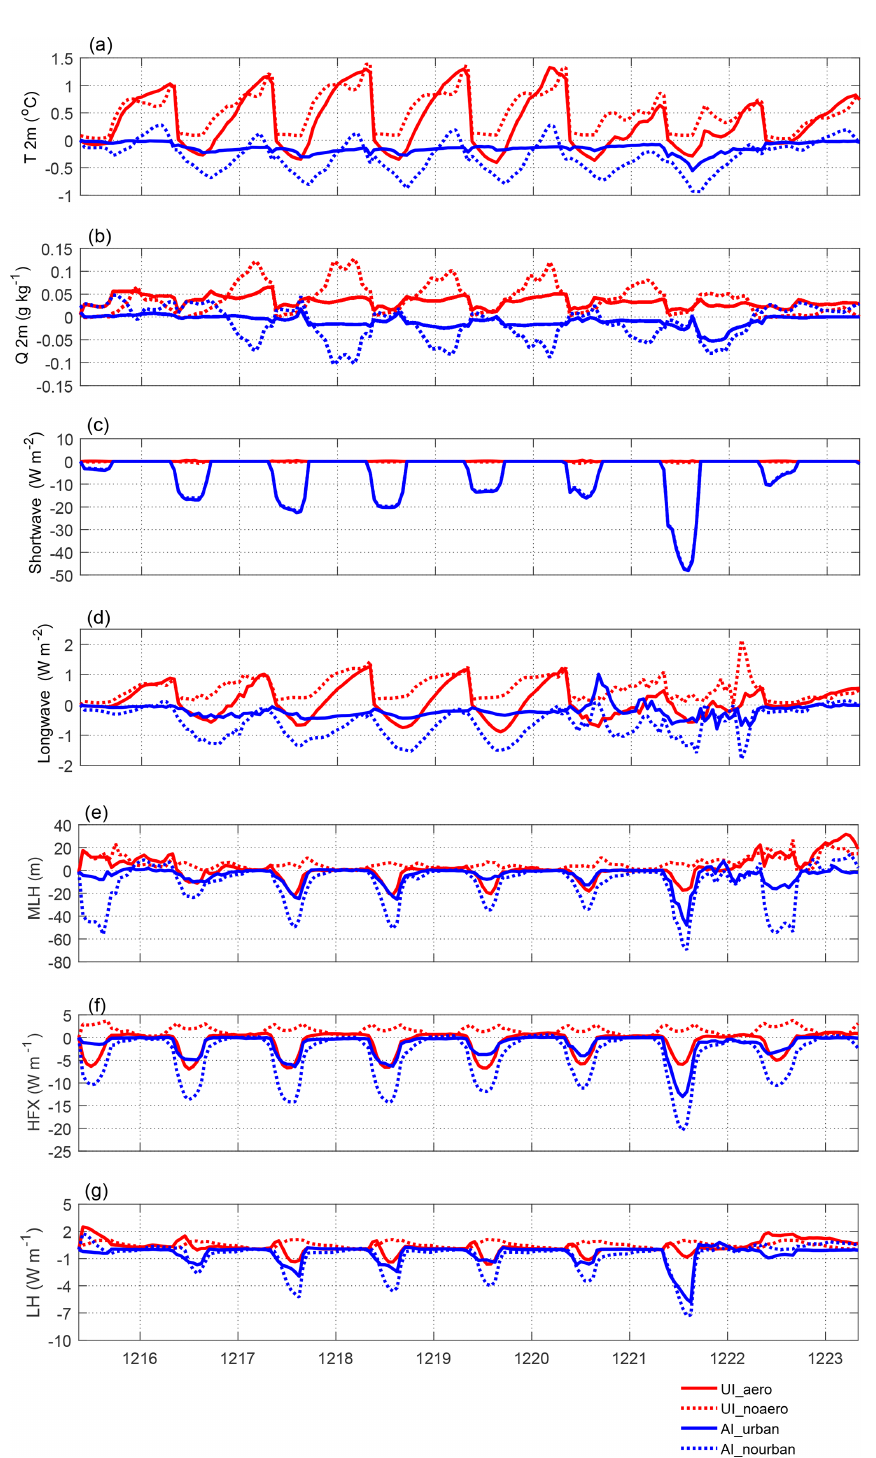
Figure 6. Diurnal patterns of simulated variables from 15 to 23 December. (a) Temperature at 2m ( T ; ◦ C); (b) specific humidity ( Q ; gkg − 1 ) at 2m; (c) shortwave radiation (Wm − 2 ); (d) longwave radiation (Wm − 2 ); (e) mixing-layer height (MLH; m); (f) sensible heat flux (HFX; Wm − 2 ); and (g) latent heat flux (LH; Wm − 2